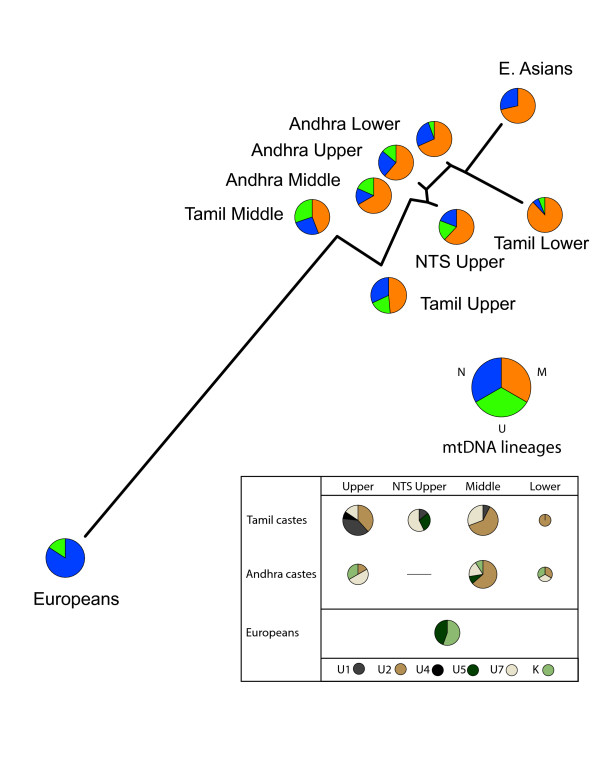
Genetic distances for mitochrondrial data. A neighbor-joining network depicts the genetic distance estimates between South Indian castes, Europeans, and East Asians for 32 mtDNA SNPs and 411 bp of HVS1 sequence. Pie diagrams indicate the proportion of major mtDNA lineages found in each population. The inset shows the proportion of mtDNA U sub-lineages. Inset circle size is proportional to the total number of U lineages.